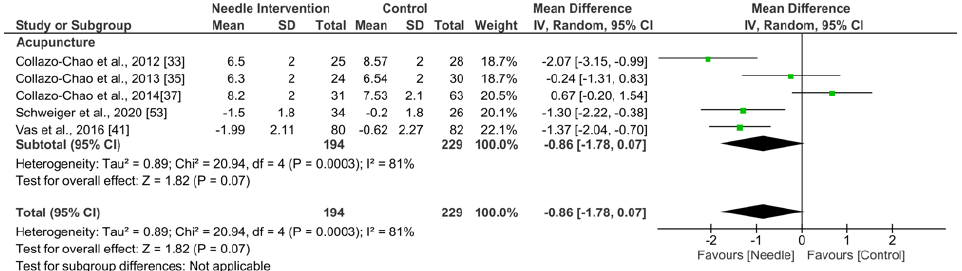
Figure 4. Forest plot for Pain Intensity: +6 months.